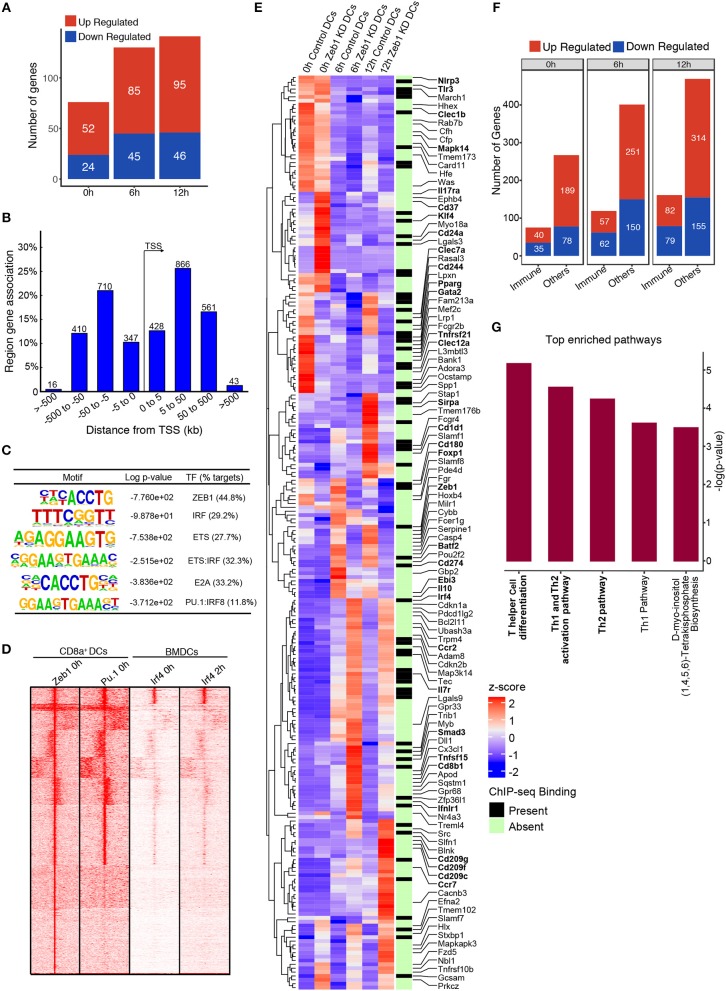
Integrative genomic analysis using ChIP-seq and RNA-seq identified that Zeb1 does not act as global repressor of immune response genes. (A) Bar-plot depicting the genes that were directly regulated (upregulated and down-regulated) by Zeb1 KD at 0, 6, and 12 h after CpG activation in cDC1 DCs. The direct target genes of Zeb1 were identified by correlating the gene list from Zeb1 KD RNA-seq and Zeb1 ChIP-seq binding analysis. (B) Genomic Regions Enrichment of Zeb1 ChIP-seq bound peaks by annotations tool GREAT showing the genomic locations of Zeb1 bound regulatory regions with respect to gene transcription start sites (TSS). (C) List of top de-novo motifs significantly enriched at the Zeb1 bound peaks in unstimulated DCs and their annotated TFs. Zeb1 motif was found to be the top highly enriched motif. (D) SeqMINER clustering demonstrating the overlap of Zeb1 bound peaks in unstimulated CD8α+ cDC1 with PU.1 bound genomic regions in similar condition. The peaks were also overlapped with IRF4 ChIP-seq publicly available data of control and LPS stimulated primary BMDCs. (E) Heat-map demonstrating the immune response pathway genes that were differentially regulated after Zeb1 KD 0, 6, and 12 h after CpG activation as compared to control cells. The ChIP-seq binding was also overlapped to identify if Zeb1 directly regulates immune response genes. All the immune response genes that were differentially regulated (>2-fold up or down-regulated) are listed. The genes that were reported and are important in Th cell polarization through DCs are highlighted in bold. To generate this bar-graph Z-score was calculated for each gene from normalized FPKM values to demonstrate the differential regulation of genes in control and Zeb1 KD DCs at 0, 6, and 12 h after CpG activation. (F) Bar-plot depicting the differential regulated genes in Zeb1 KD DCs at 0, 6, and 12 h after CpG activation. The genes were classification into two different groups based on GO annotation i.e., immune response genes (immune) and other pathway genes (others). It was observed that in immune response gene group there is preferential upregulation of genes after Zeb1 KD whereas in the other group there was higher number of upregulated genes (>1.6- to 2.5-fold) compared to down-regulated ones. (G) Bar-plot showing the IPA pathways significantly enriched for the genes that were directly bound and regulated by Zeb1 at 12 h after CpG activation.